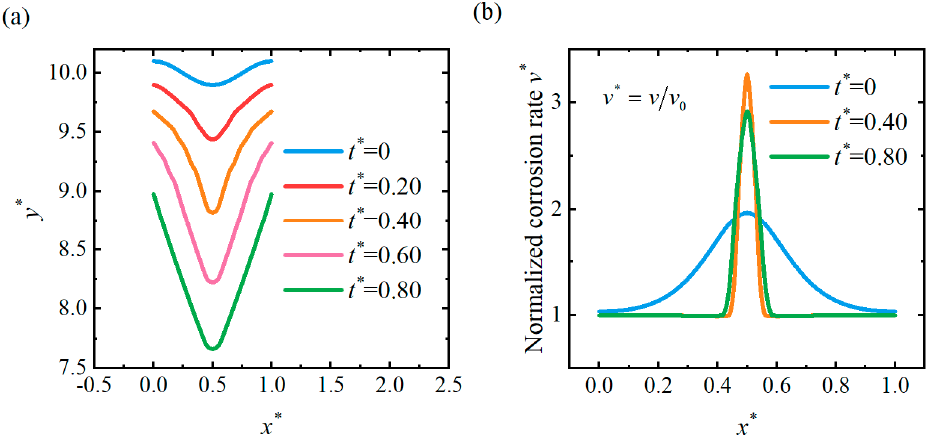
Figure 11. ( a ) Surface morphology evolution process and ( b ) corrosion rate distribution when A ∗ = 0.1 and σ A = 50